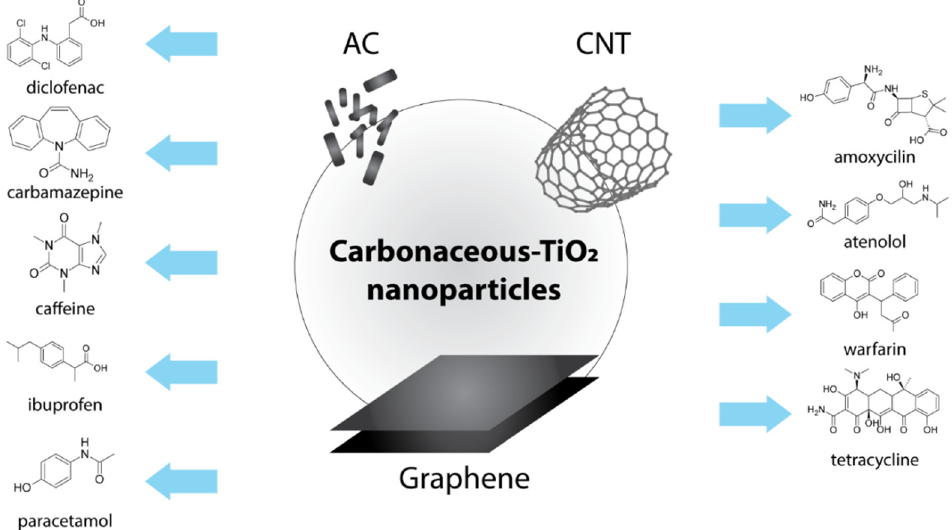
Figure 10. The applicability of carbonaceous-TiO 2 nanomaterials as catalysts in the photodegradation studies of various pharmaceutically active ingredients; carbon nanotube (CNT), activated carbon (AC).